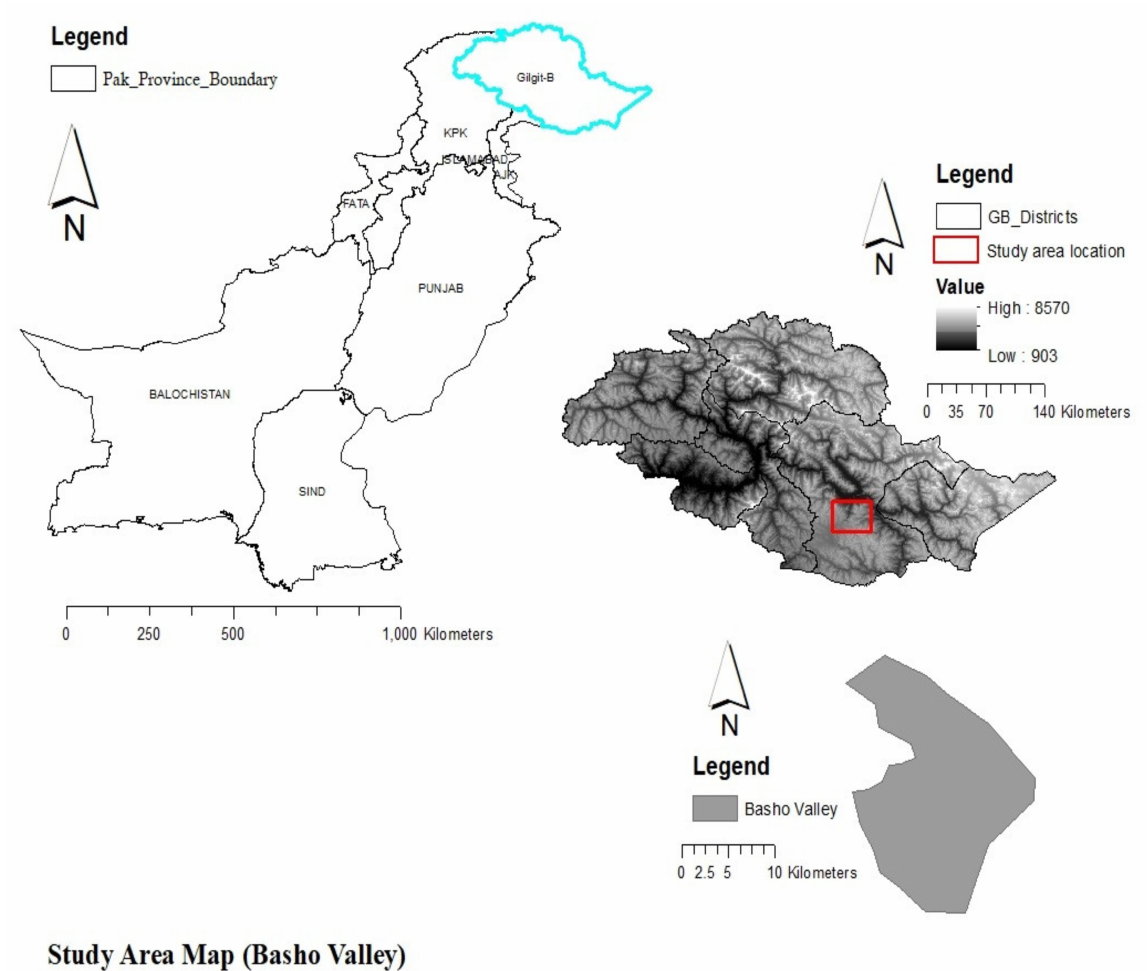
Figure 2. Map of Baltistan region in the northern areas of